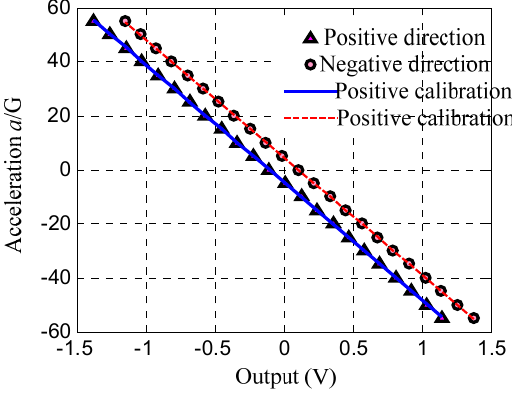
Figure 6. The test results in two directions.